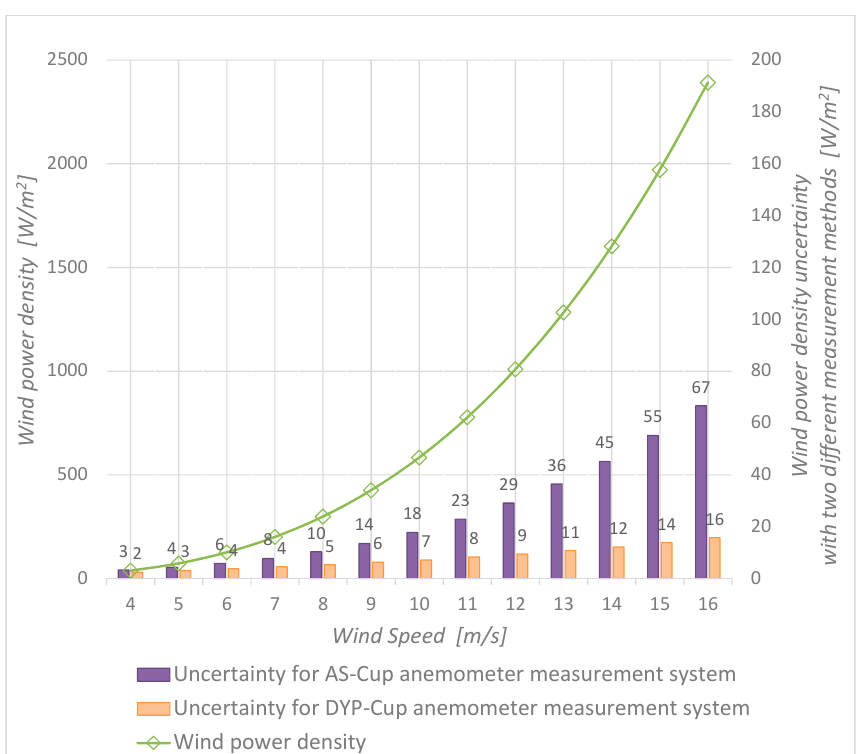
Figure 10. Wind power density uncertainty by means of the alternative and the conventional method.